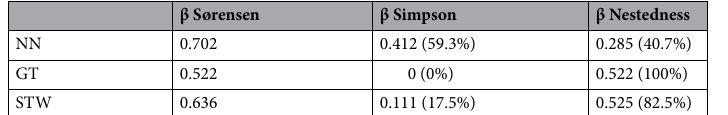
Table 2. β Sørensen dissimilarity index between the new assemblages and the Paris Biota defined at Paris Canyon, together with the β Simpson (accounting for species turnover) and β Nestedness dissimilarity components. Taxa identified as new but most probably also present at Paris Canyon have been considered as present in the Paris Canyon assemblage (e.g., coelacanth and Bobasatrania ). Numbers in brackets represent the percentage of explained total